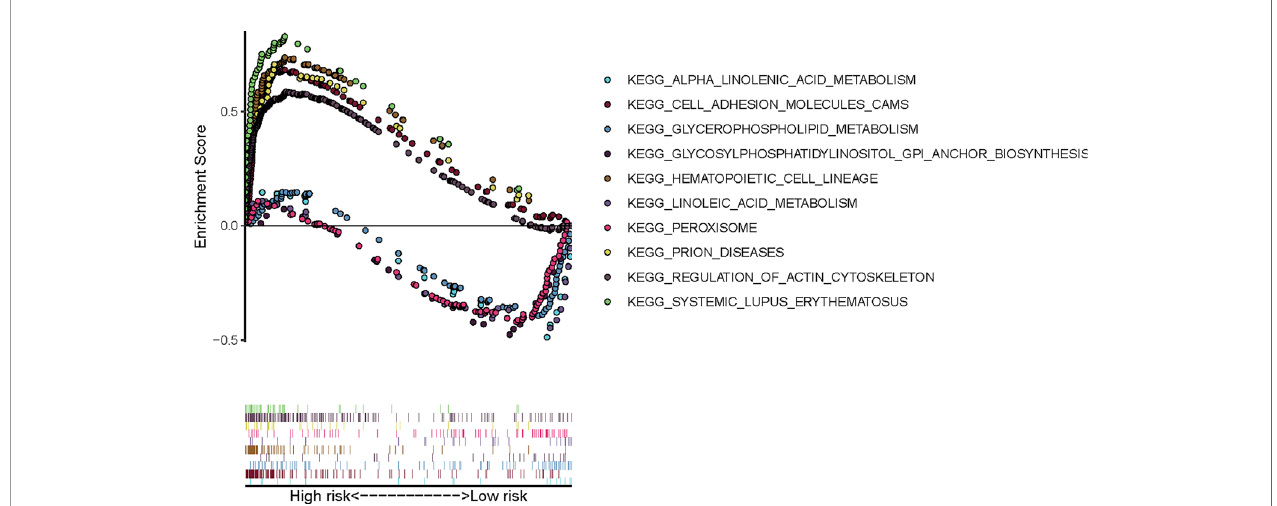
FIGURE 8 | Gene Set Enrichment Analysis of our prognostic FRG signature in TCGA-BLCA cohort. FRG, ferroptosis − related gene; TCGA, The Cancer Genome Atlas; BLCA, bladder cancer.